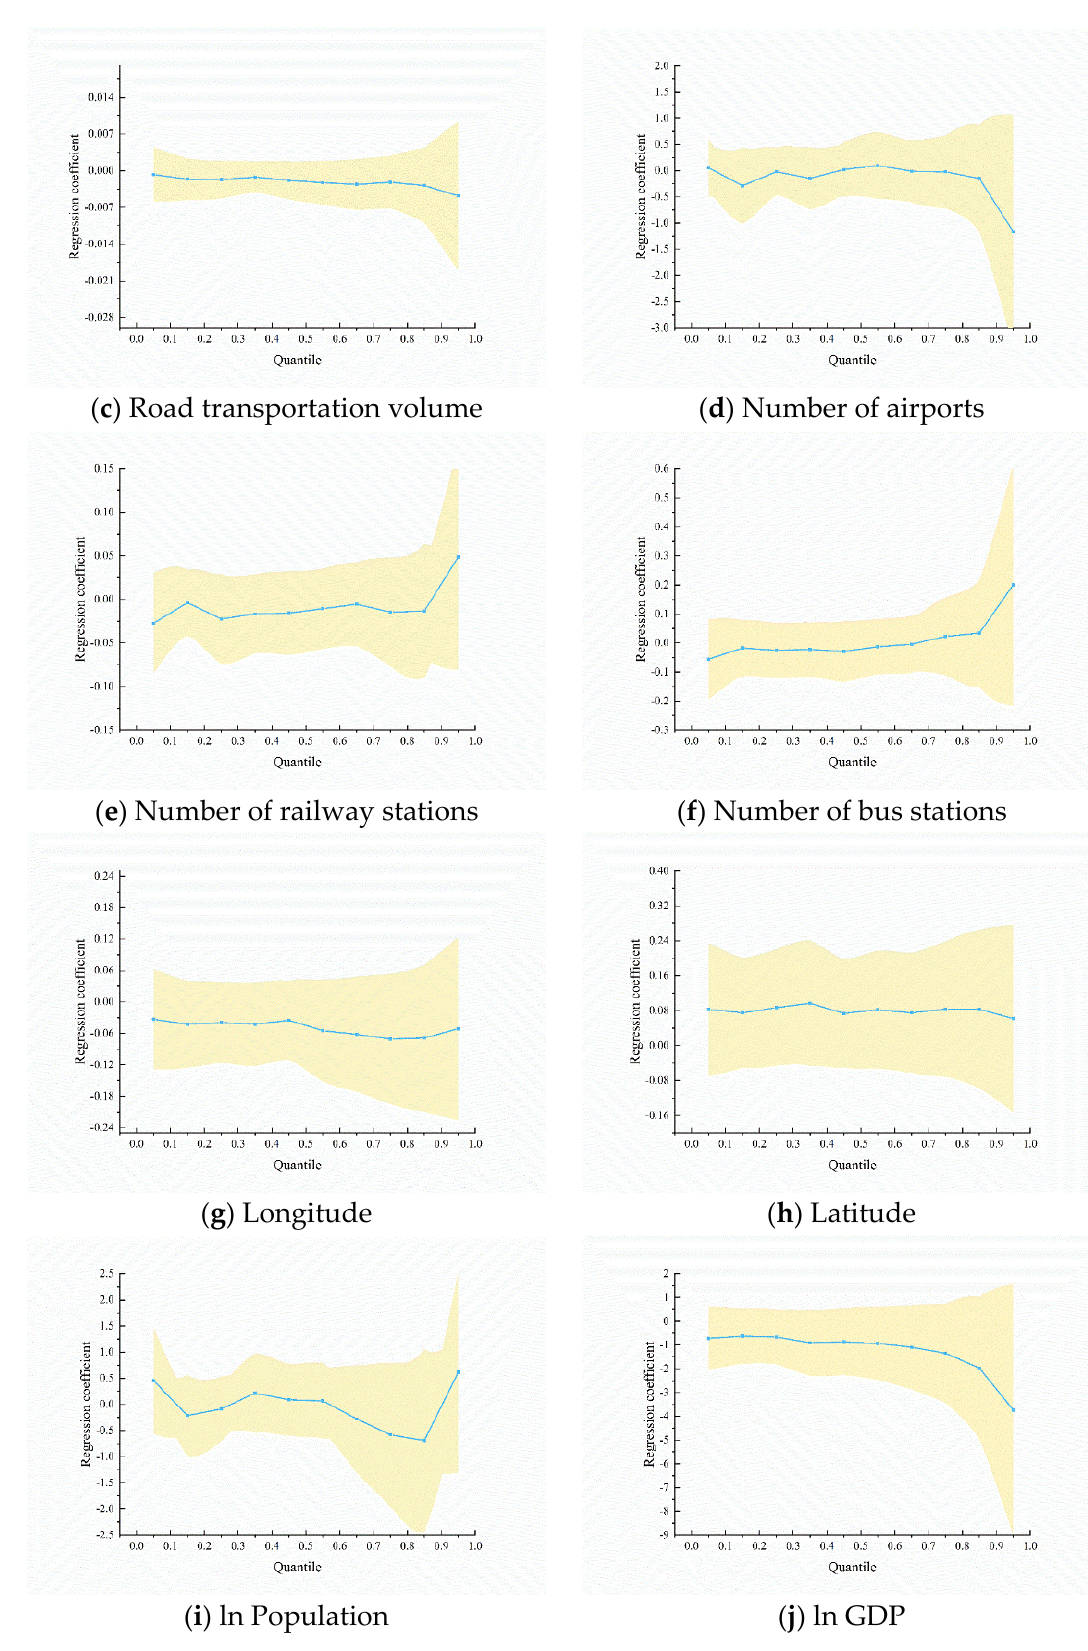
Figure 5. The regression coefficients for quantiles of variables.